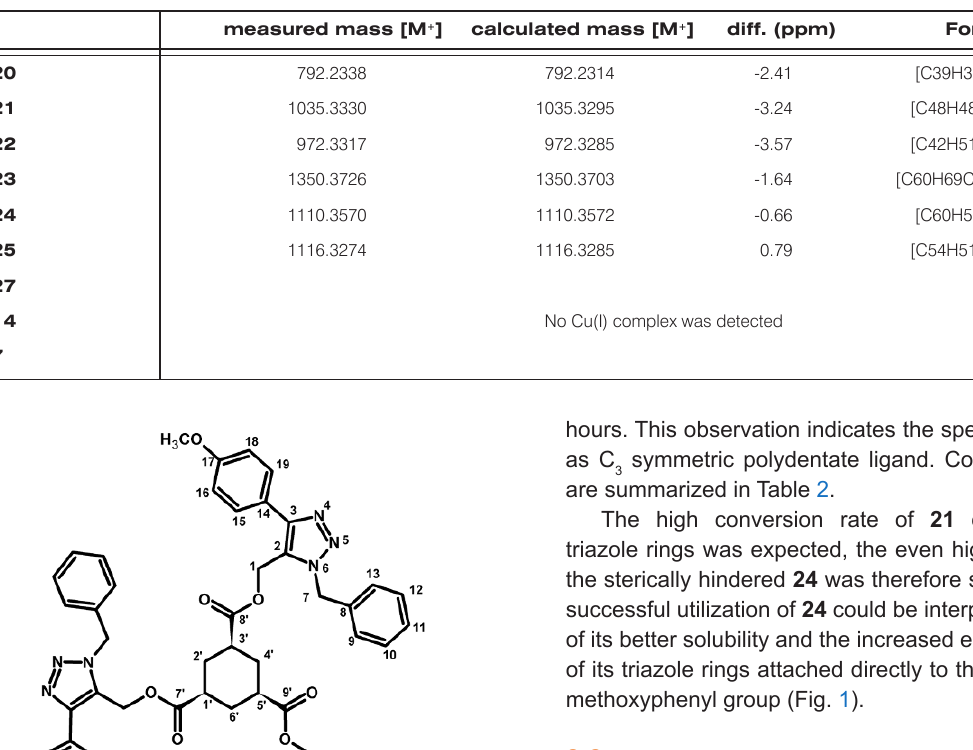
Table 3. HRMS data of copper(I)-complexes.